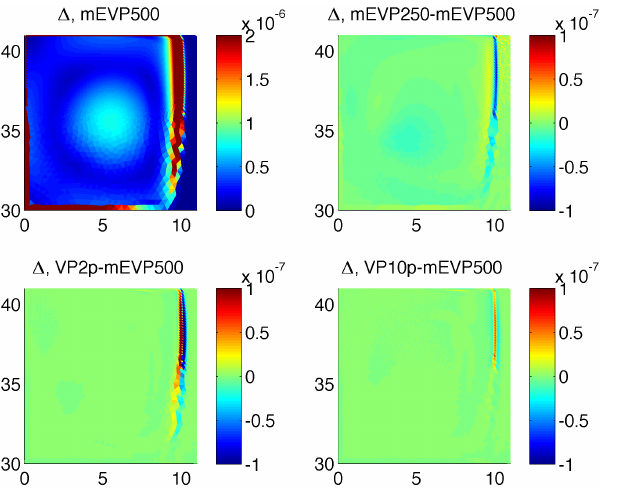
Figure 5. (cid:49) (s − 1 ) after 1 month of simulations in case B in mEVP500 (top left) and differences between the solutions: VPb- mEVP500 (top right), VP10p-mEVP500 (bottom left) and VP25p- mEVP500 (bottom right). Additional Picard iterations in the VP method lead to substantially reduced differences between the so- lutions in the northeast corner. VPb reproduces a much stronger ice (smaller (cid:49) ), but additional Picard iterations make it weaker and closer to